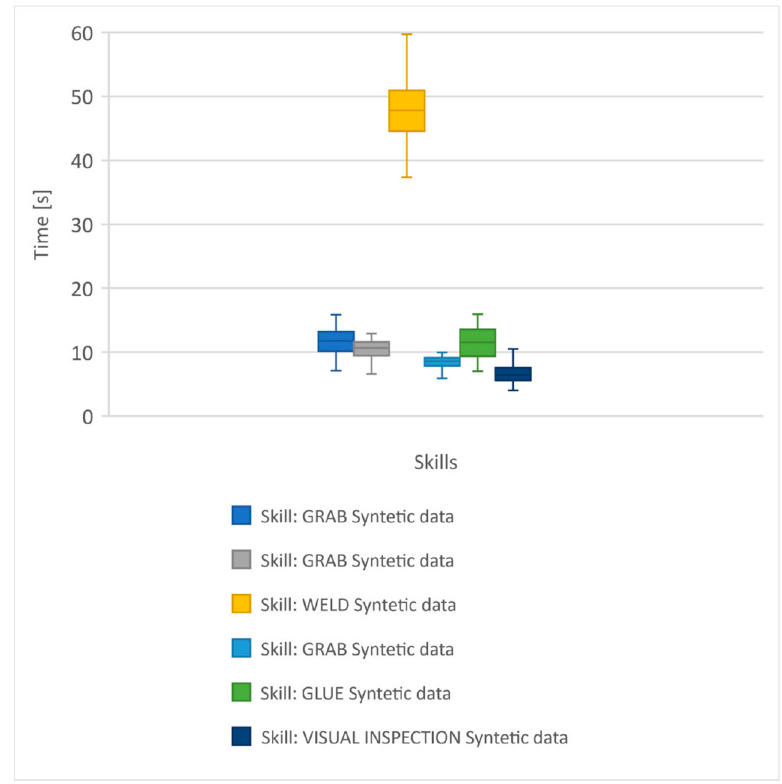
Figure 12. Time-based datasets used as synthetic data for the implementation case.